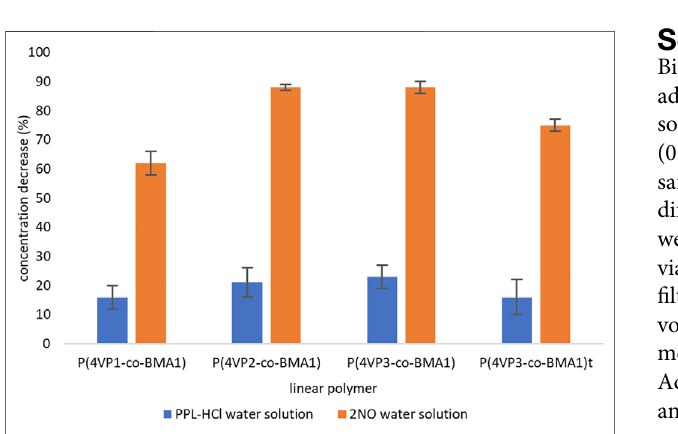
Frontiers in Chemistry |